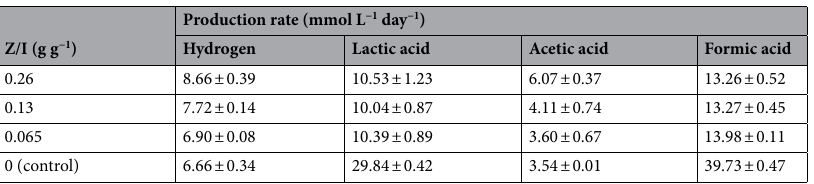
Table 2. Estimated production rates for hydrogen, lactic, acetic and formic acid in the batch experiments with C5 and C6-sugars in the presence and absence of zeolite.